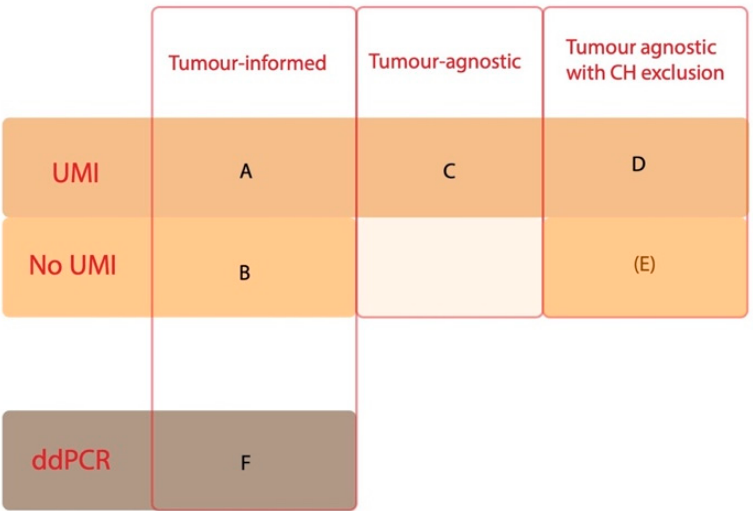
Figure 2. Variant filtering approaches. Three different bioinformatic technical approaches were used (headings on the x -axis): tumour-informed (=only tissue variants included), tumour-agnostic (=all filtered plasma variants included) and tumour-agnostic with CH exclusion (=all tissue variants included, except those excluded as CH by the white blood cell analysis or paired sample comparisons). Three different techniques were investigated (headings on the y -axis): sequencing with UMIs, with- out UMIs and ddPCR (digital droplet PCR). Each letter ( A – F ) is referred to in detail below. UMI, unique molecular identifiers; ddPCR, digital droplet PCR; CH, clonal haematopoiesis.